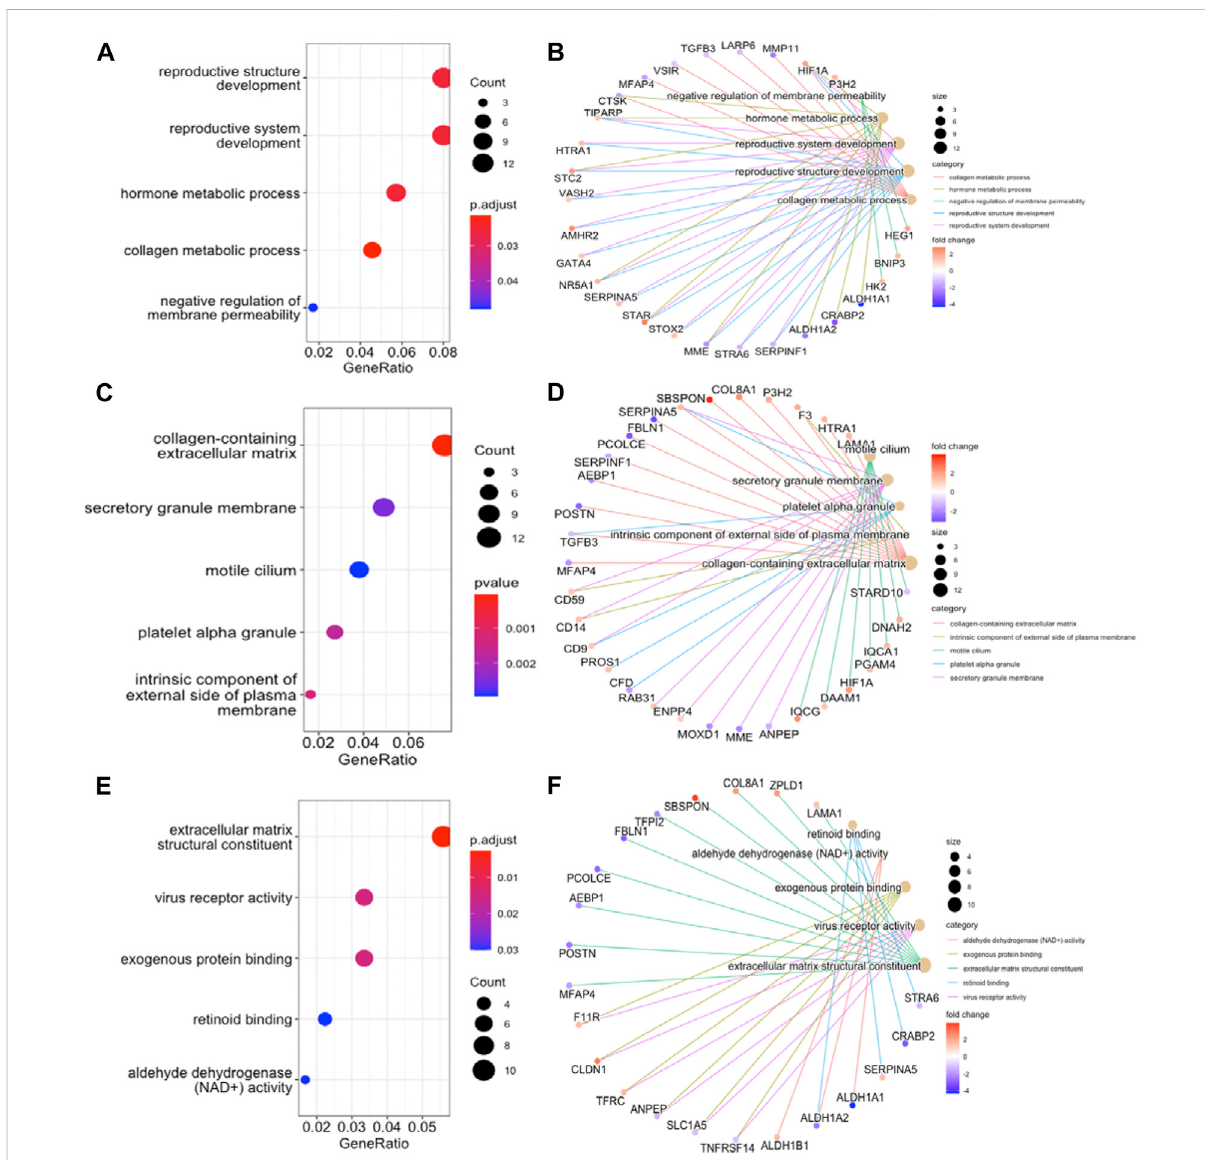
GOFunctionalAnnotationAnalysis.TheGOanalysisdisplayedtop fi veenrichedtermsaboutBP,CCandMF. (A) , (C) ,and (E) .dotplotforBP,CC, MF enrichment analysis of DEGs. (B) , (D) , and (F) . the relationship between DEGs and each term. MF, molecular function; BP, biological process; CC, cellular